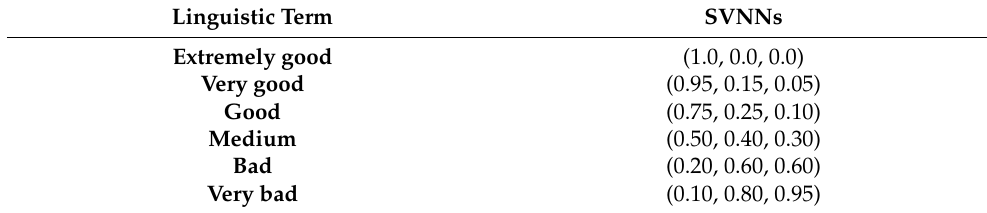
Table 1. Ranking of attributes and decision makers with linguistic